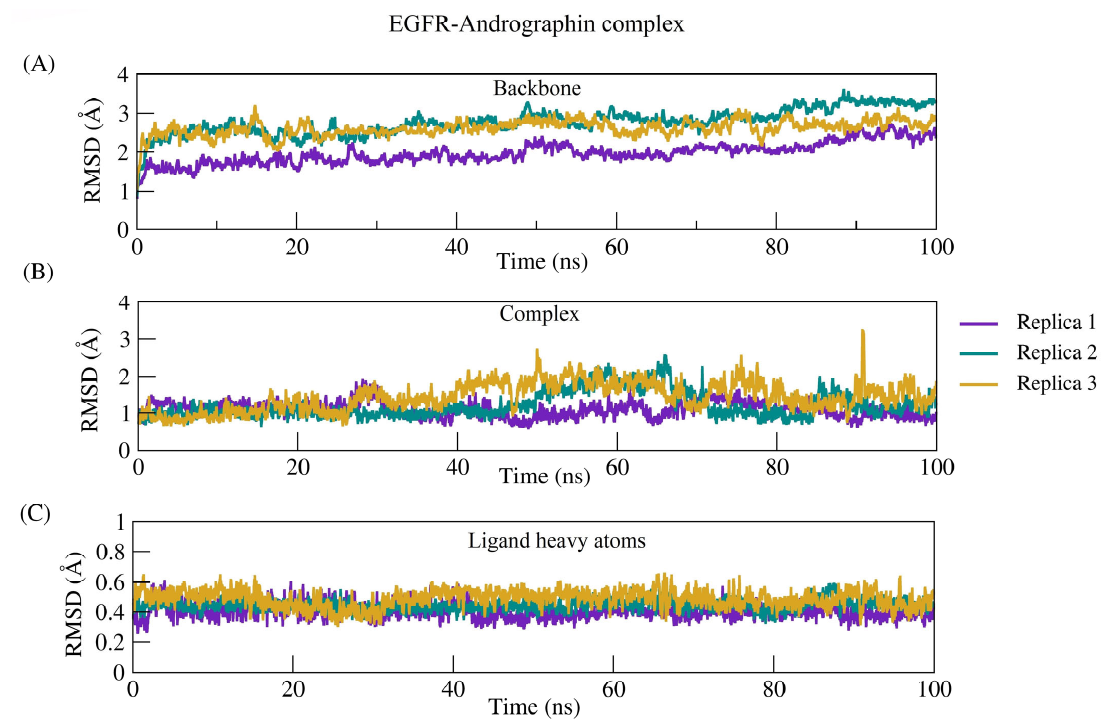
Figure 6. Andrographin with WT–EGFR 100 ns MD production run. ( A ) RMSD plot depicting the “Protein Backbone”. ( B ) Plot depicting the docked complex stability “ligand–protein complex RMSD”. ( C ) Plot depicting the stability of “ligand w.r.t. ligand”.